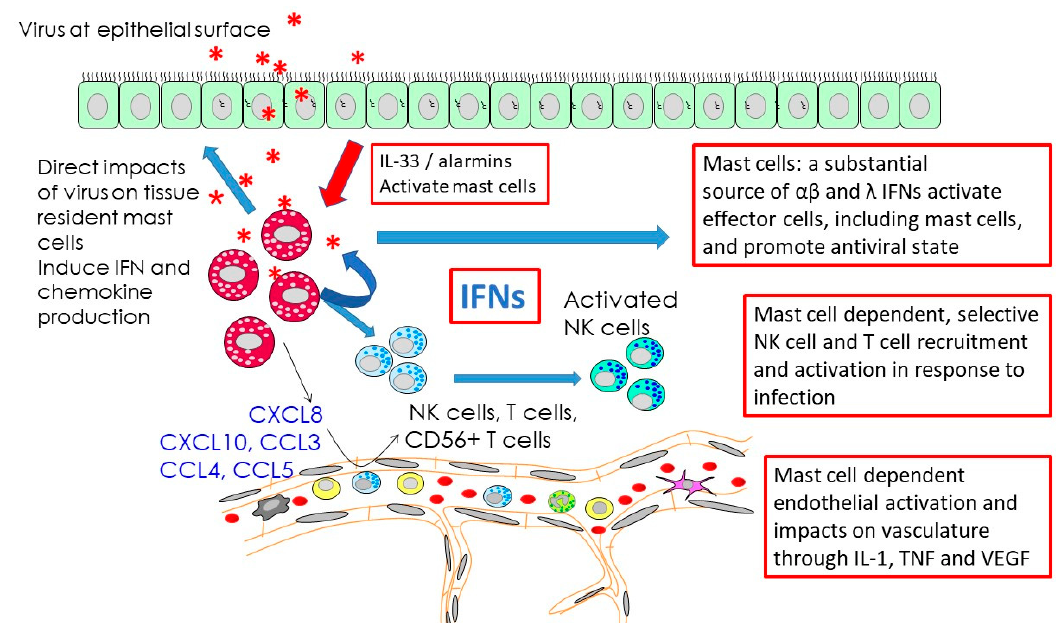
Figure 1. Selected, critical and early mast cell (MC) responses to viral infections which occur without a requirement for MC degranulation. MCs can be activated directly by active viral infection or by contact with viral particles. They can also be activated by alarmins released as a result of infection of neighboring or epithelial cells. This MC activation leads to the production of multiple mediators including large amounts of type I interferons (IFNs) and type III IFNs by virus infected human cells. While inducing an antiviral state in neighboring cells, such IFN responses also initiate multiple additional responses (blue arrows), the expression of a number of chemokines which together with MC-derived cytokines enhance the local recruitment of e ff ector cells such as NK cells, T cells, and CD56-positive T cells from local blood vessels and promote the activation of NK cells, enhancing their cytotoxic functions. Such IFNs also act in an autocrine fashion to further promote selected mediator production by MCs.